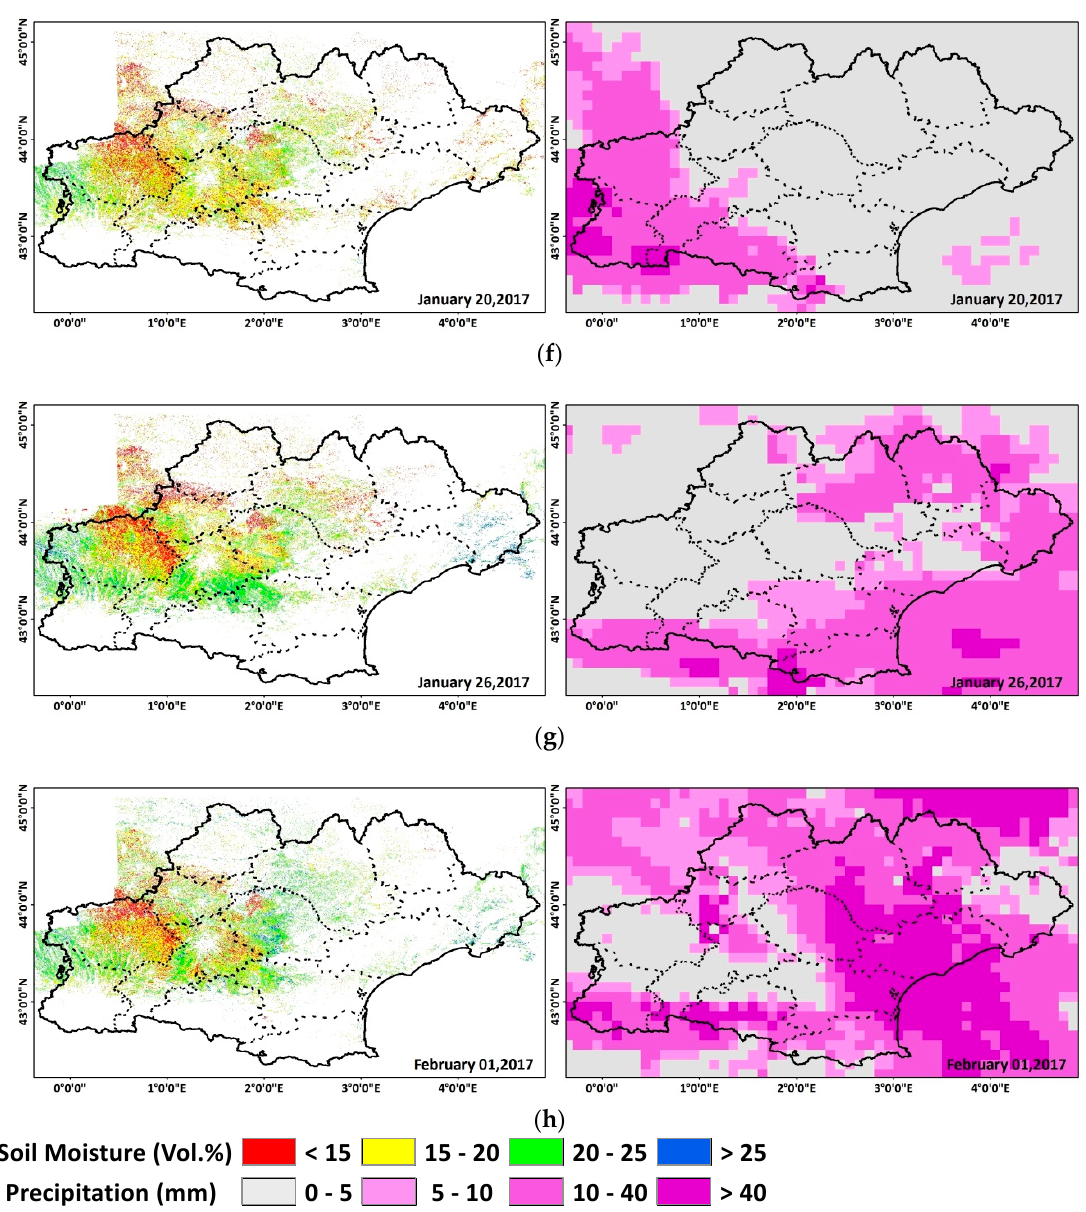
Figure 3. On the left, an S1-derived SSM map. On the right, the corresponding six days of GPM cumulative precipitation data. ( a ) 21 December 2016, ( b ) 27 December 2016, ( c ) 2 January 2017, ( d ) 8 January 2017, ( e ) 14 January 2017, ( f ) 20 January 2017, ( g ) 26 January 2017, and ( h ) 1 February 2017. Departments are represented by dashed lines.